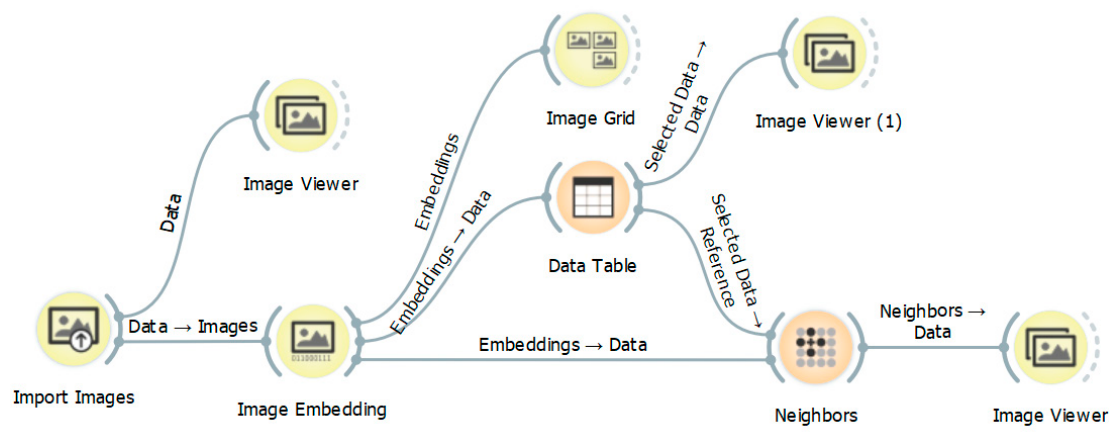
Figure 4. Workflow with the Image Embedding and Neighbors widgets in Orange.